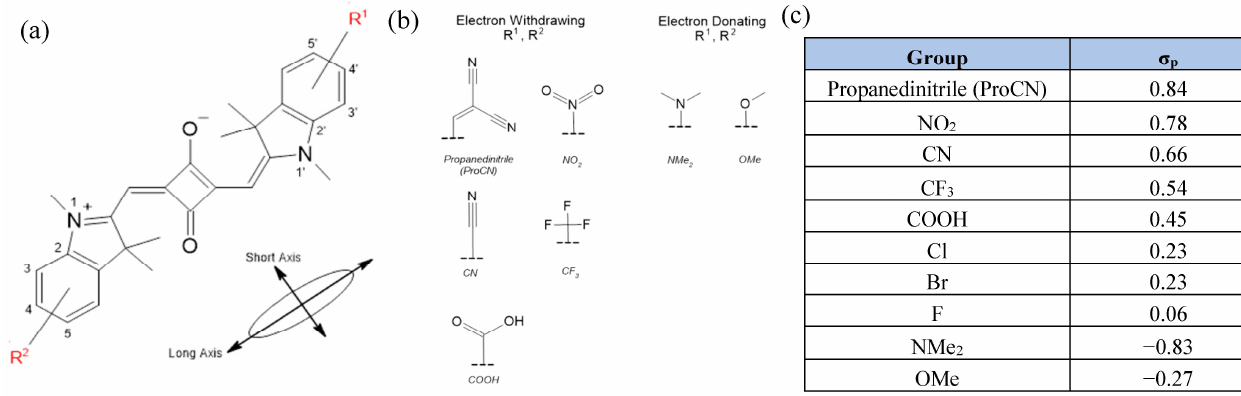
Figure 1. ( a ) Base molecular structure of an indolenine-based squaraine (SQ), with relevant substituent locations labeled. Electron-withdrawing groups (EWGs) are located on positions 3, 4, or 5, and electron-donating groups (EDGs) are located on the positions 3′, 4′, and 5′. ( b ) Chemical structures of the substituents used in this study, and ( c ) table of Hammett constants for all substituents, where negative Hammett constant indicates electron donating character and a positive Hammett constant indicates electron withdrawing character. [48,49].